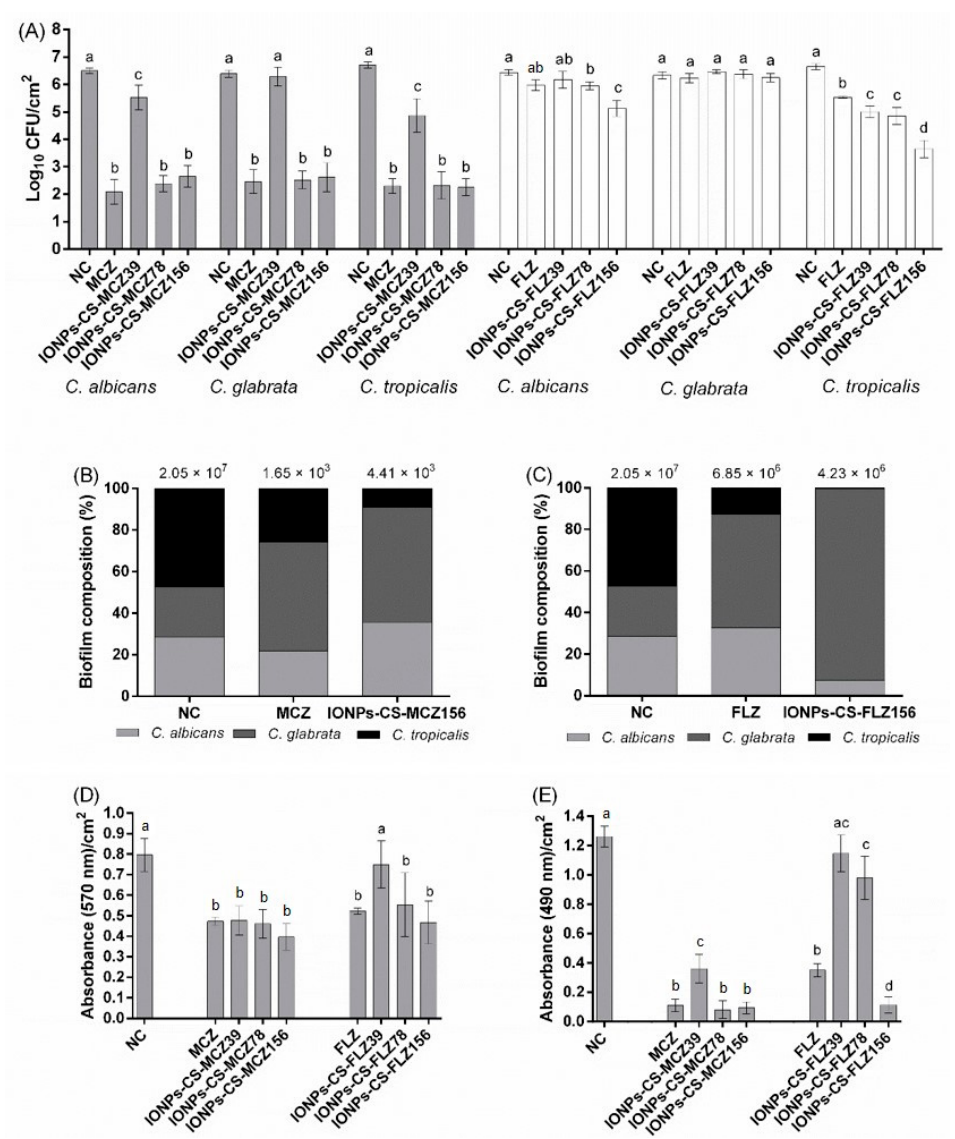
Figure 1. Colony-forming units quantification ( A ), compositional analysis ( B , C ), total biomass ( D ), and metabolic activity ( E ) of 48 h mixed biofilms of Candida albicans , Candida glabrata , and Candida tropicalis after treatment with different compounds. Biofilms were treated during 24 h with miconazole (MCZ) at 156 µg/mL, chitosan (CS)-coated iron oxide nanoparticles (IONPs) carrying MCZ at 39 (IONPs-CS-MCZ39), 78 (IONPs-CS-MCZ78), and 156 µg/mL (IONPs-CS-MCZ156), fluconazole (FLZ) at 156 µg/mL, and FLZ-containing nanocarrier at 39 (IONPs-CS-FLZ39), 78 (IONPs-CS-FLZ78), and 156 µg/mL (IONPs-CS-FLZ156). Biofilms grown for 72 h in artificial saliva devoid of drugs depict the negative control (NC). Distinct lower-case letters depict significant differences among the groups within each drug (one-way ANOVA and Fisher LSD’s test; p < 0.05). Statistical analyses were conducted separately for each antifungal agent, its nanocarriers, and NC. IONPs-CS-FLZ156 was the most effective compound in reducing CFUs of C. albicans